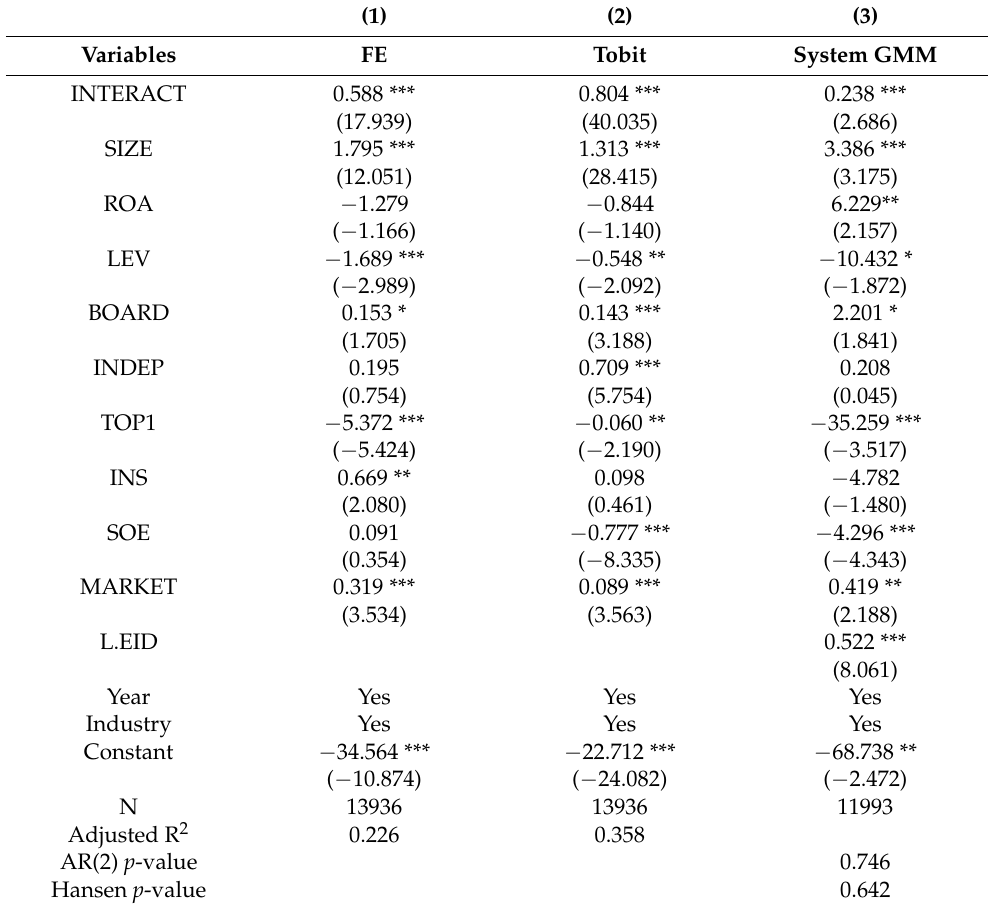
Table 6. Results of alternative estimation